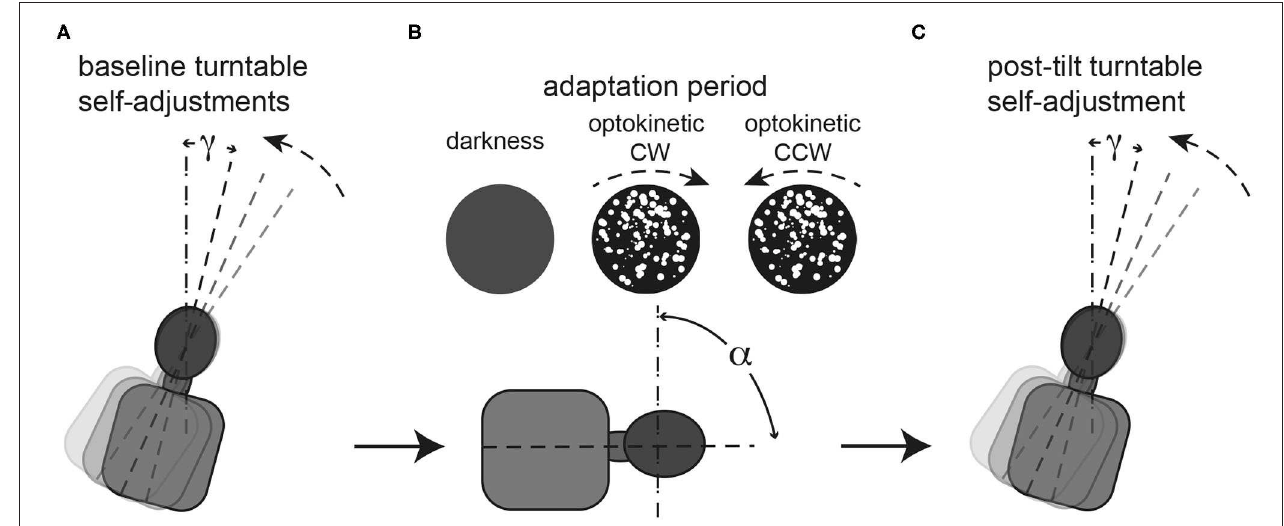
FIGURE 1 | Illustration of the required task at baseline (A) , during the 5-min adaptation period (B) and immediately afterwards (C) . (A) : repetitive baseline turntable self-adjustments starting from 90 ◦ right-ear down (RED) and 90 ◦ left-ear-down (LED) in random order (for illustrative purposes only a single trial starting from 90 ◦ RED is show) along the perceived earth-vertical are collected. Angle g represents the deviation of the turntable self-adjustments relative to earth-vertical, thus for perfect self-adjustments along earth-vertical g = 0. (B) : during the adaptation period, subjects remain in a static roll-tilted position (referred to as a, set to ± 90 ◦ , only 90 ◦ RED shown for illustrative purposes) either in darkness (“no optokinetic stimulation” condition) or while watching an optokinetic stimulus that is rotating in either clockwise (“optokinetic CW” condition) or counter-clockwise (“optokinetic CCW” condition) direction. No self-adjustments are performed during this period. (C) : Single turntable self-adjustment along perceived earth-vertical in darkness (i.e., no optokinetic stimulus is shown) after the adaptation period. Again, g represents the deviation of the turntable self-adjustments relative to earth-vertical.